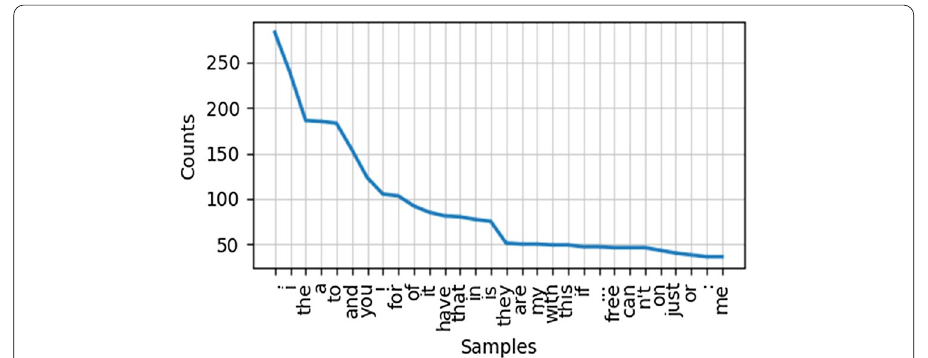
Fig. 3 Top 50 tokens before normalizing and cleaning